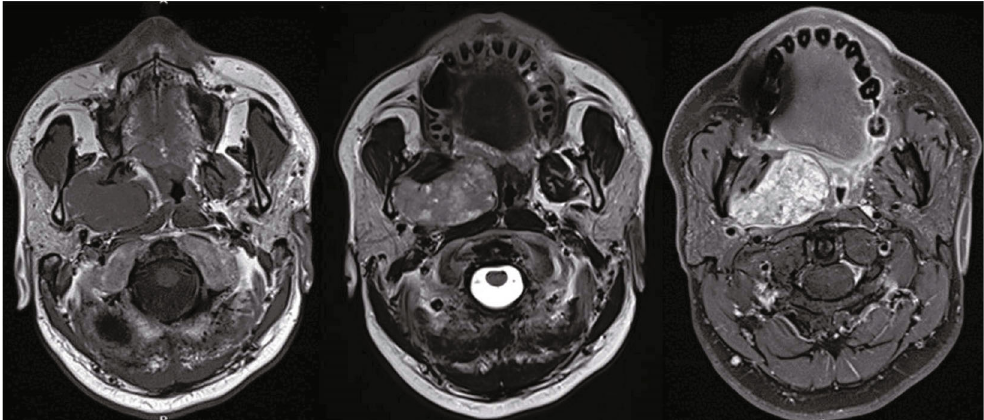
Figure 1: Facial MRI in axial sections weighted T1, T2, and T1 injected (from left to right): prestyloid parapharyngeal tumor independent of the parotid deep lobe with heterogeneous T2 hypersignal and enhancement after gadolinium